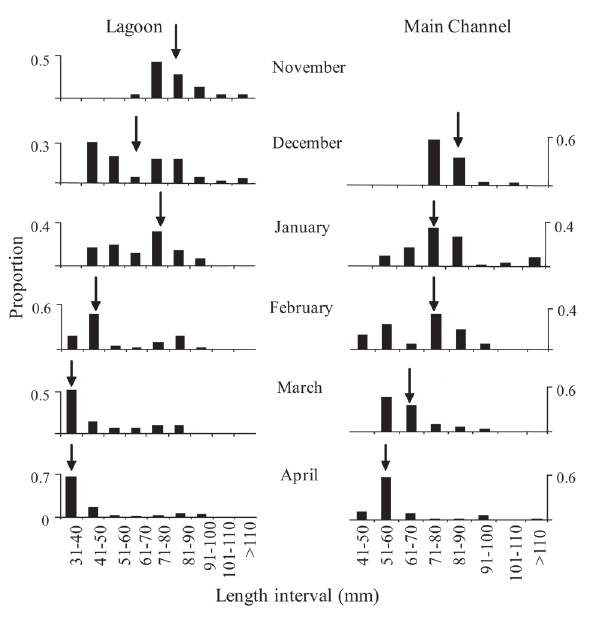
Fig. 6 . Frequency histogram of the largest (SL) 5% of individuals collected each month in seine hauls. Larger individuals became increasingly rare from November to April as water levels fall. Arrows indicate the median size for each